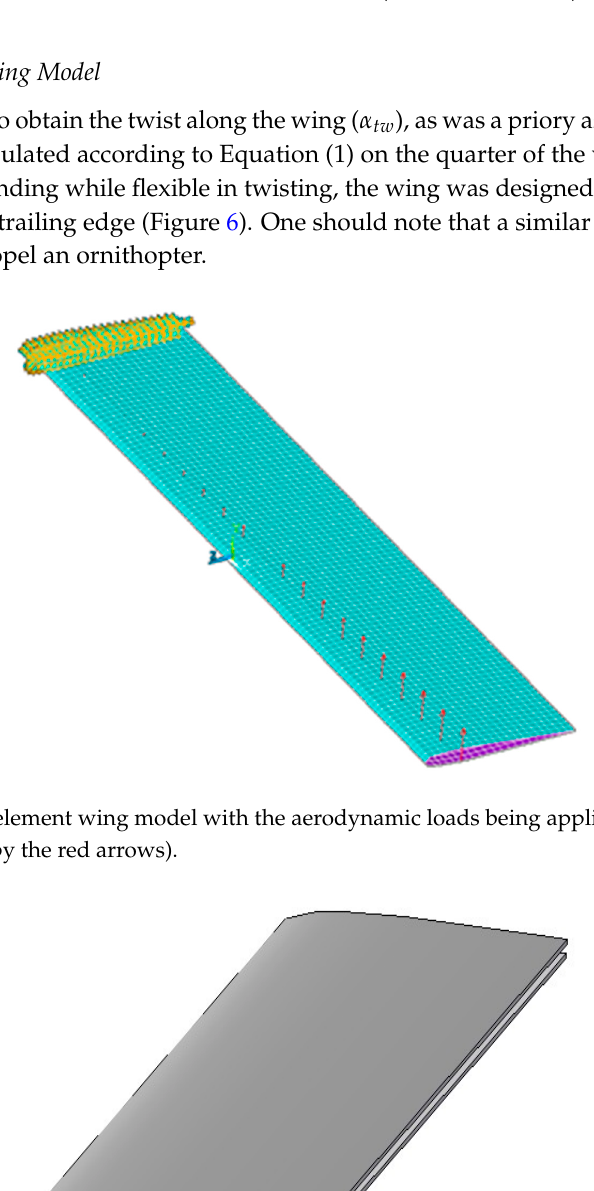
Figure 7. The deformedfinite element model. To generate an axis of rotation for the wing, a 20 cm long fiberglass tube was glued inside the wing, close to its leading edge (Figure 8).